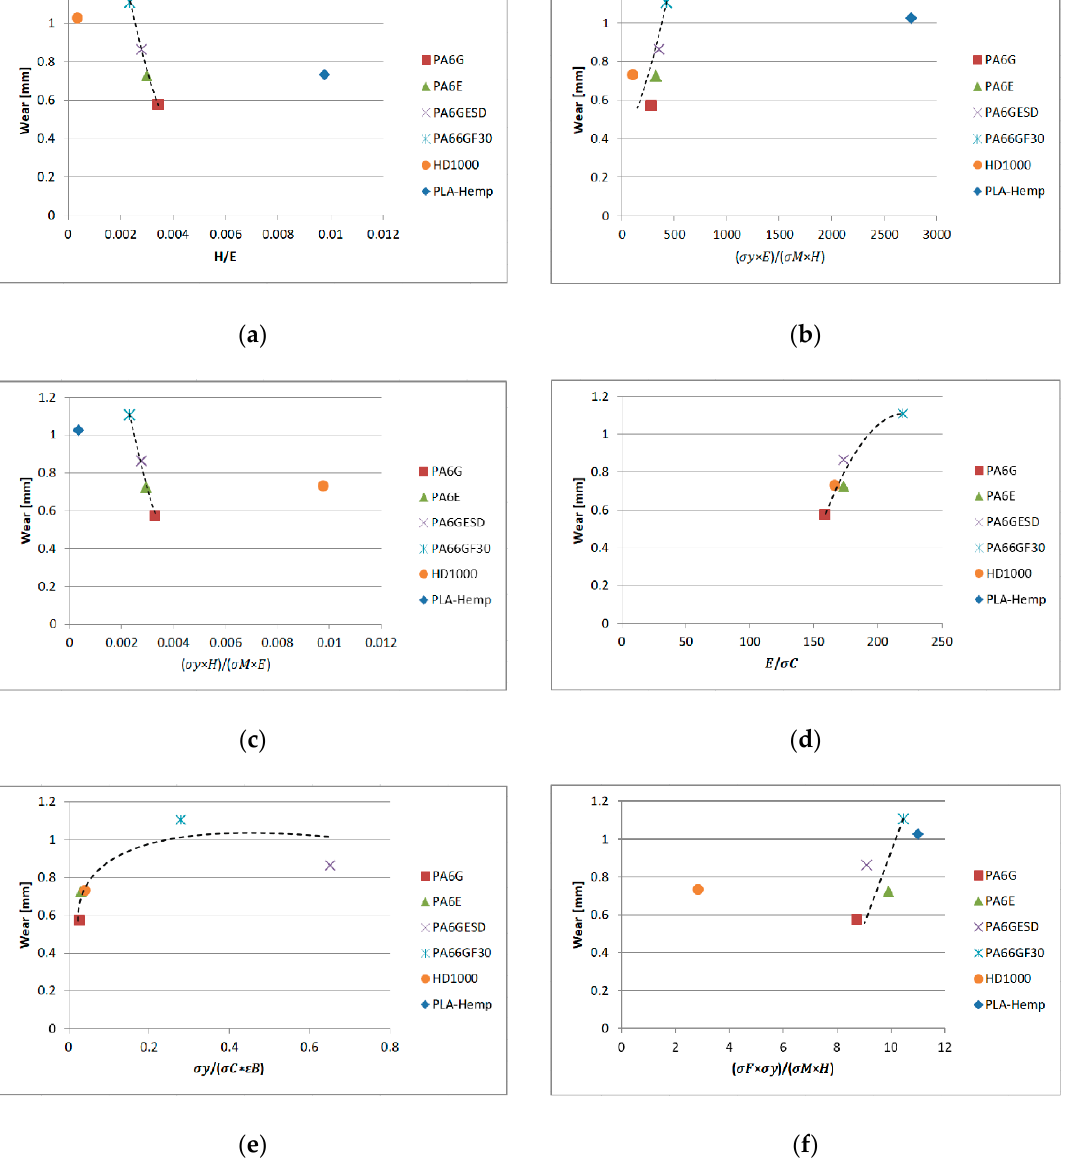
Figure 9. Wear at the end of tests plotted against dimensionless numbers combined with mechanical